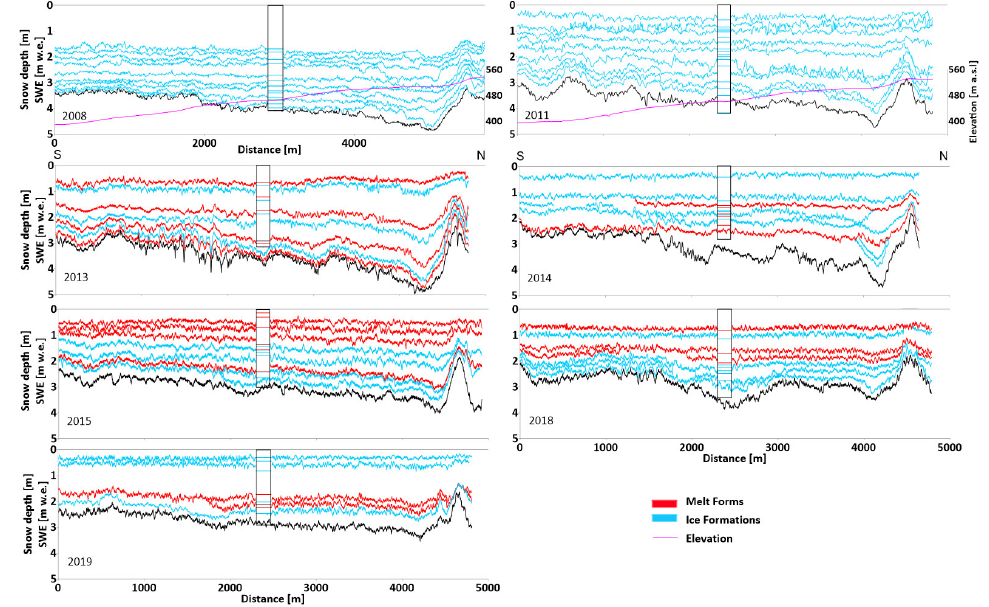
Figure 5. Ice Formations and Melt Forms. Vertical bars on the GPR profiles denote Ice Formations and Melt Forms in the snow pits. See the location of the GPR profiles on Figure 1. Grain Size